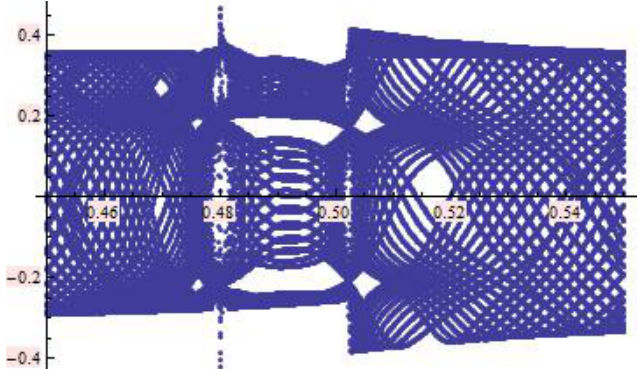
Figure 2. B.D. in ( α − x ) —plane, α between 0.45 and 0.55, β = 1.5 and the initial conditions ( 0.2,0.35 ) .